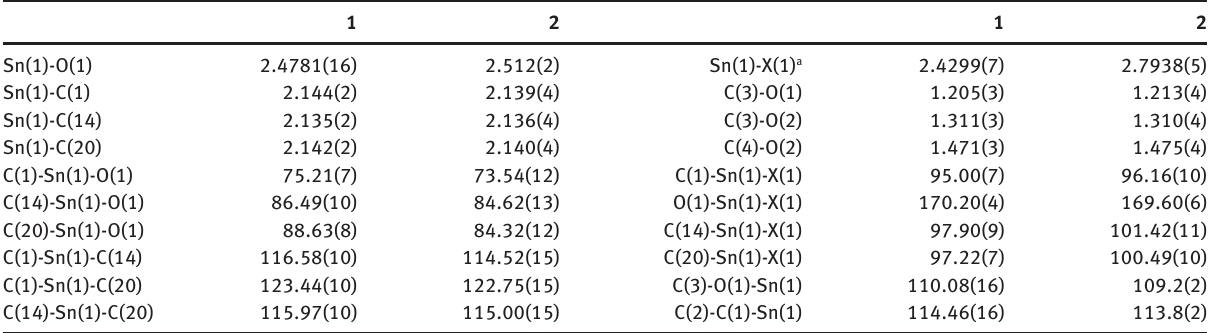
Table 1: Selected bond lengths (Å) and angles ( ° ) for 1 and 2